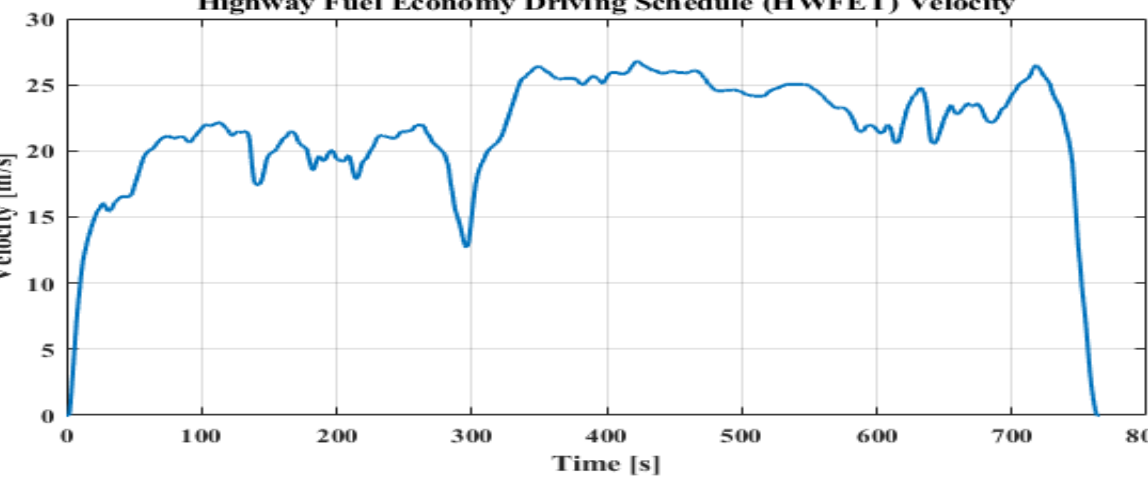
Figure 25. Drive cycle data — HWFET.